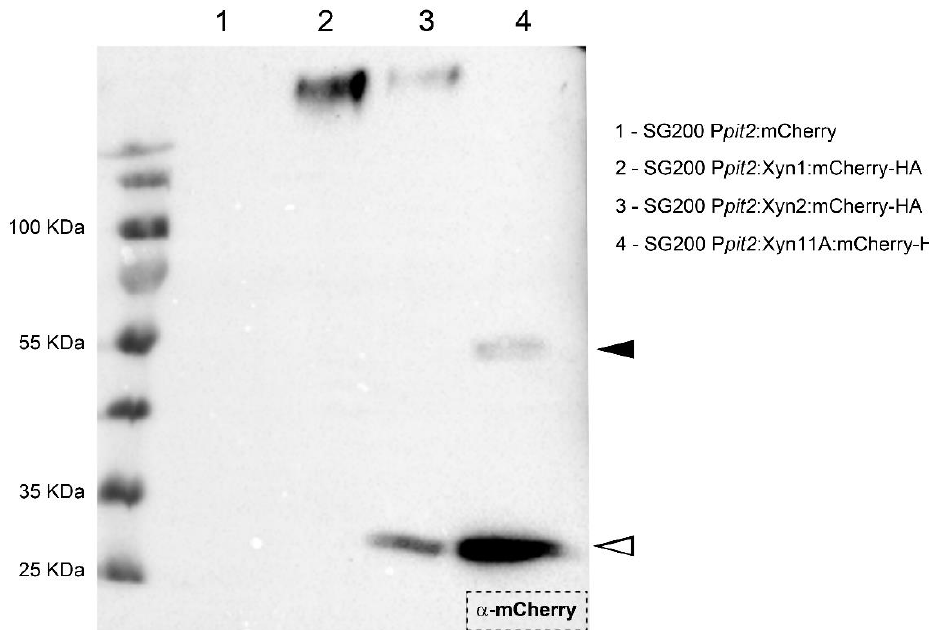
Figure 7. Xyn11A is secreted into maize apoplast. Apoplastic fluid was isolated 3 days post-inoculation from maize leaves infected with SG200 strains harboring Xyn1:mCherry-HA (2), Xyn2:mCherry-HA (3), or Xyn11A:mCherry-HA (4) under the control of pit2 promoter [43,66]. Cytoplasmic mCherry under the control of pit2 promoter in SG200 background (lane 1) was used as a control for cell lysis. Black arrowhead indicates 51 KDa band corresponding to Xyn11A:mCherry-HA and white arrowhead indicates 28.8 KDa band corresponding to free mCherry.